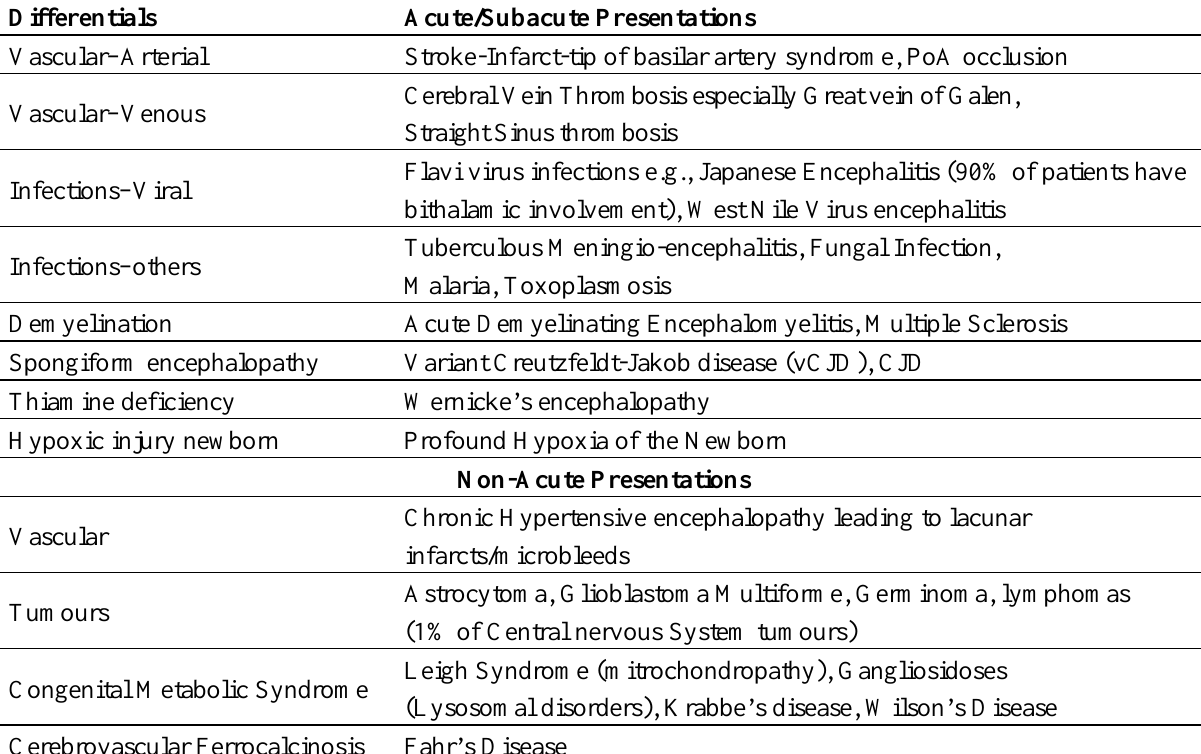
Table 1. Differentials of presentations of Artery of Percheron Infarcts